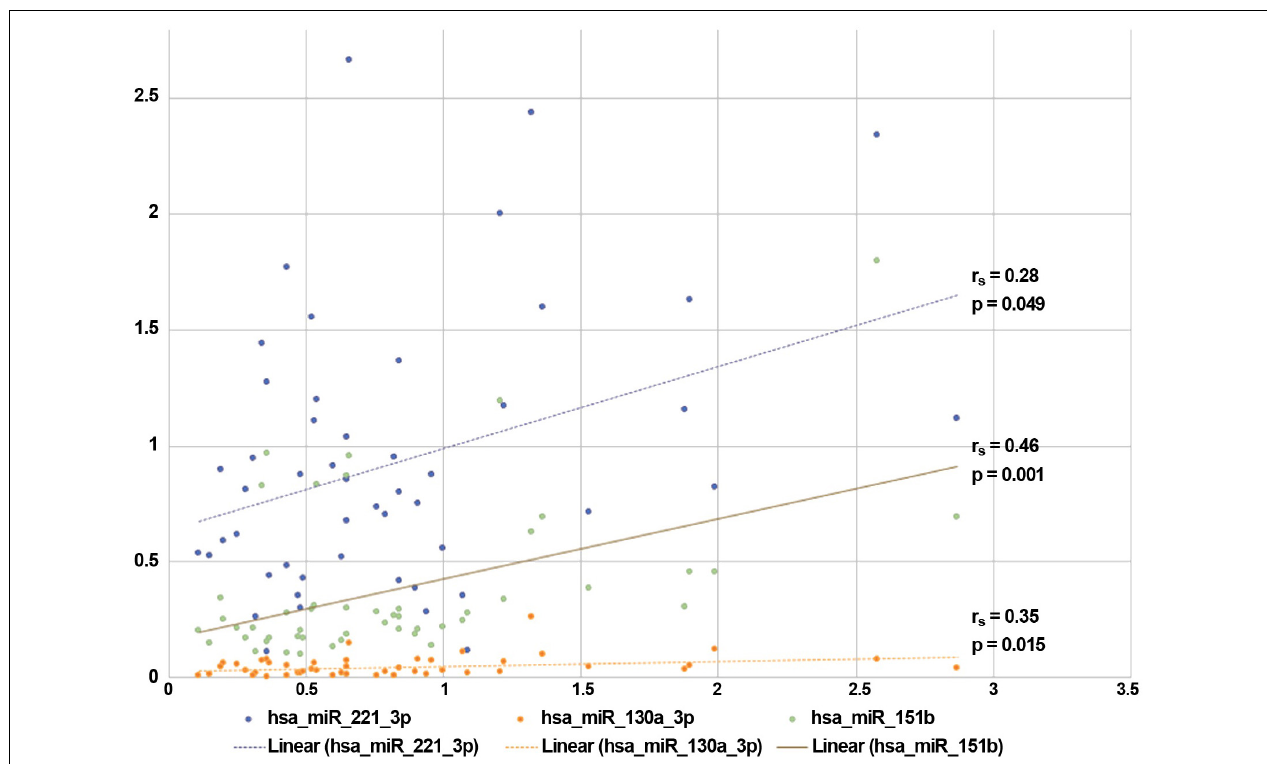
FIGURE 3 | Correlations between miRNAs expression and sALS clinical features. The expressions (fold changes) of three validated miRNAs correlated with the progression rate observed in our sALS population. ∗ Spearman rank-correlation test: p <